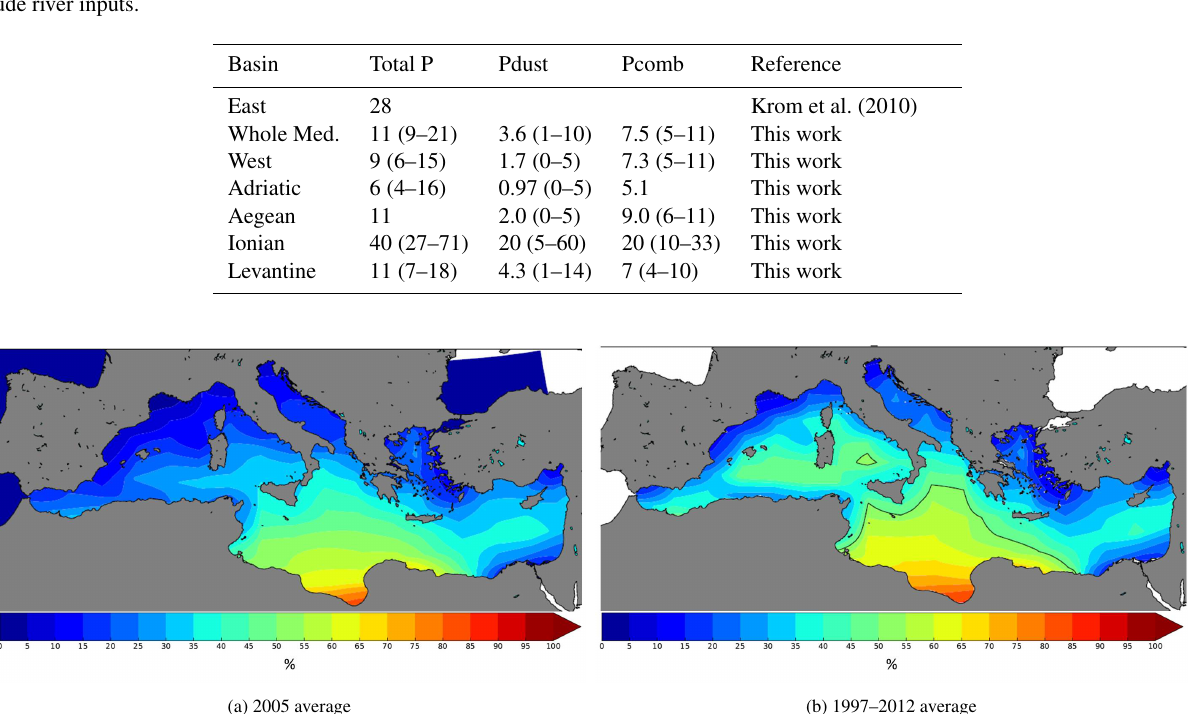
Figure 7. Map of average Pdust proportion in total P deposition for 2005 (a) and 1997–2012 (b) . The black line on the right map represents the 50% Pdust proportion limit on the average of